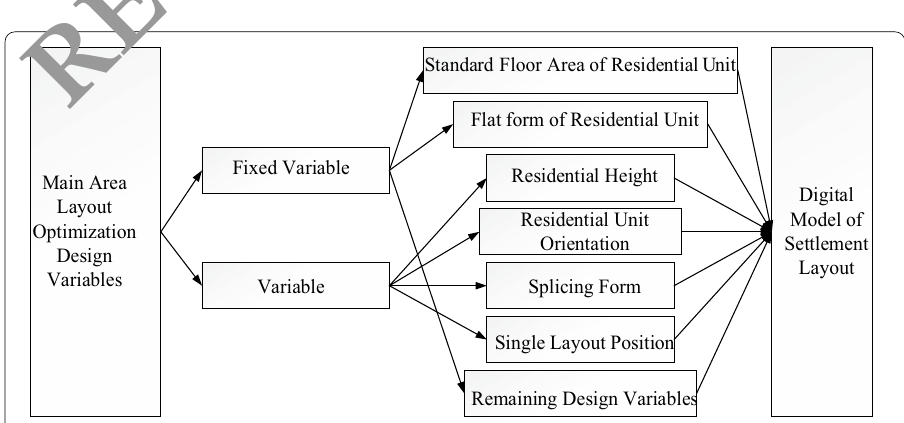
Fig. 4 Selection and classification of design variables in the phase of residential district layout